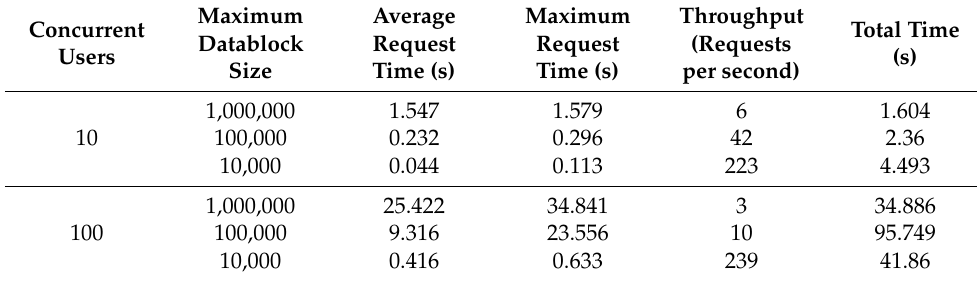
Table 8. Results of the concurrent requests test in